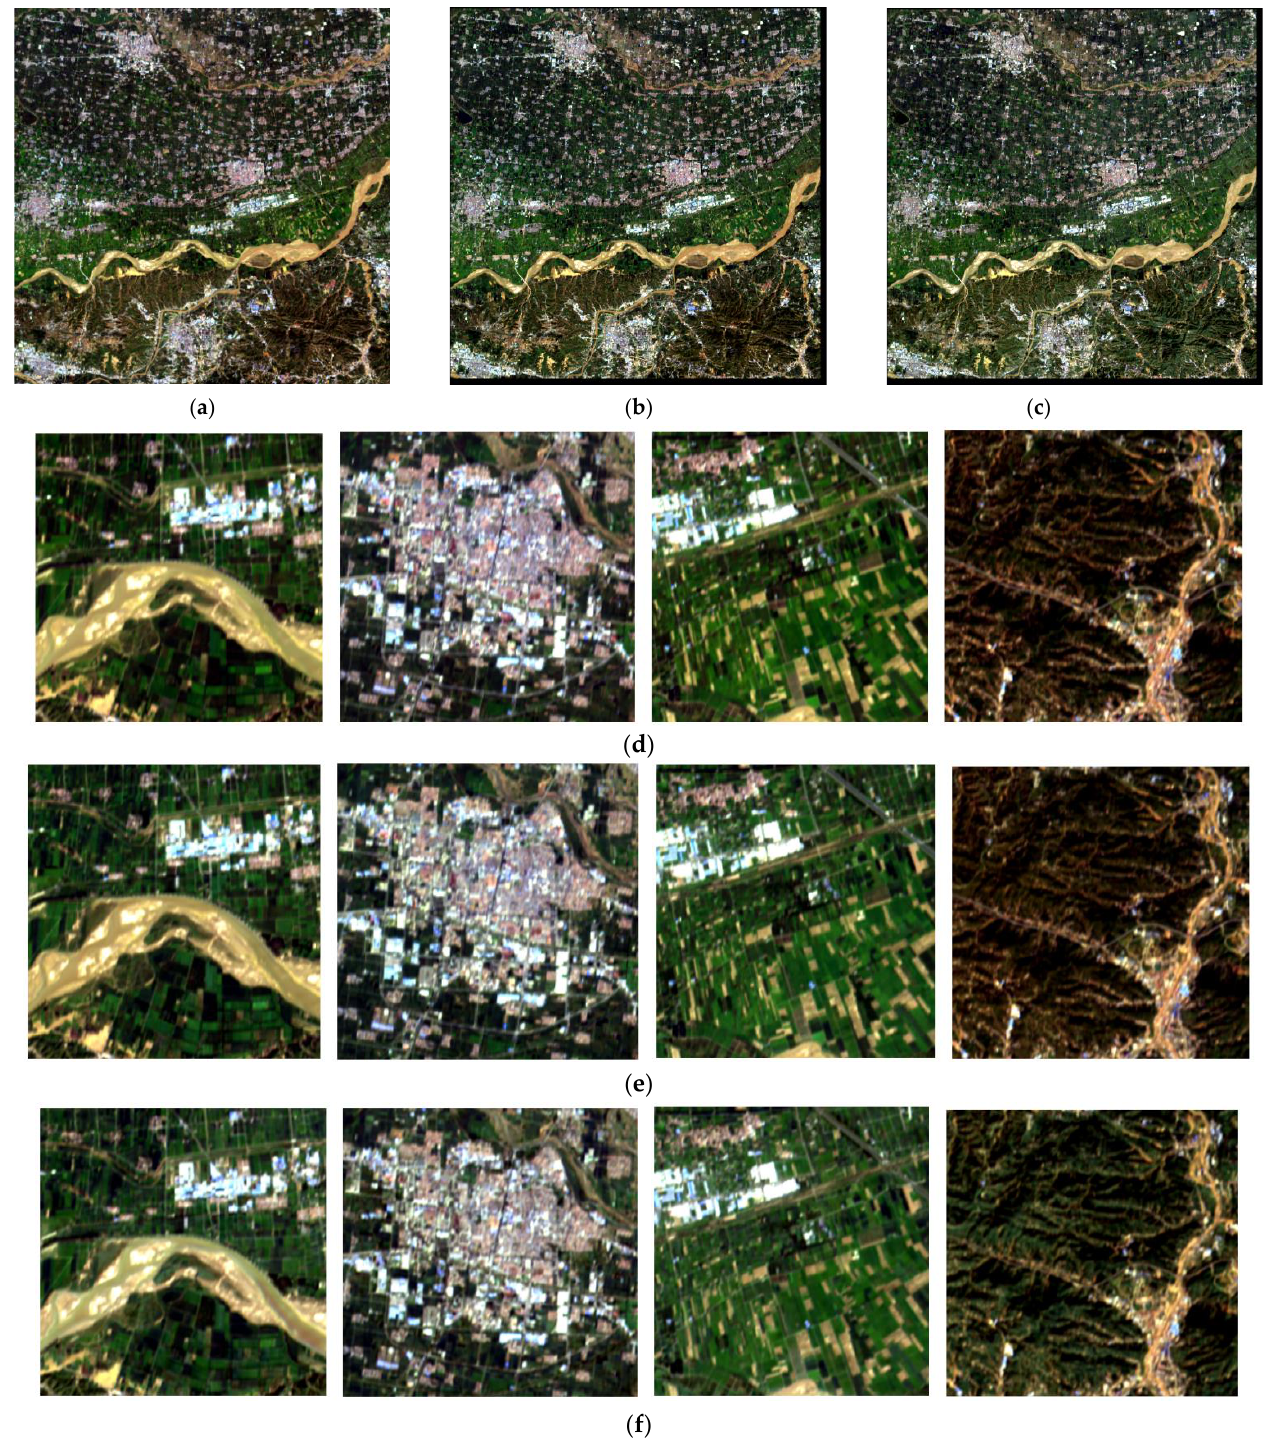
Figure 4. RGB composite of fusion result comparison between SRE-ResNet and ResNet for Dataset I. ( a – c ) are the whole scene of ground truth, prediction of SRE-ResNet and ResNet. ( d – f ) are the detailed scene of ground truth, prediction of SRE-ResNet and ResNet.